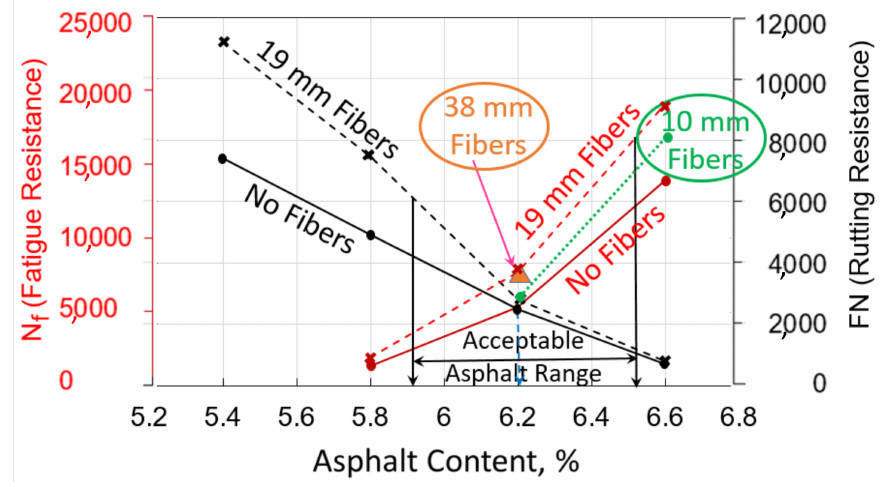
Figure 12. Effect 10 and 38 mm fibers within the acceptable range of asphalt